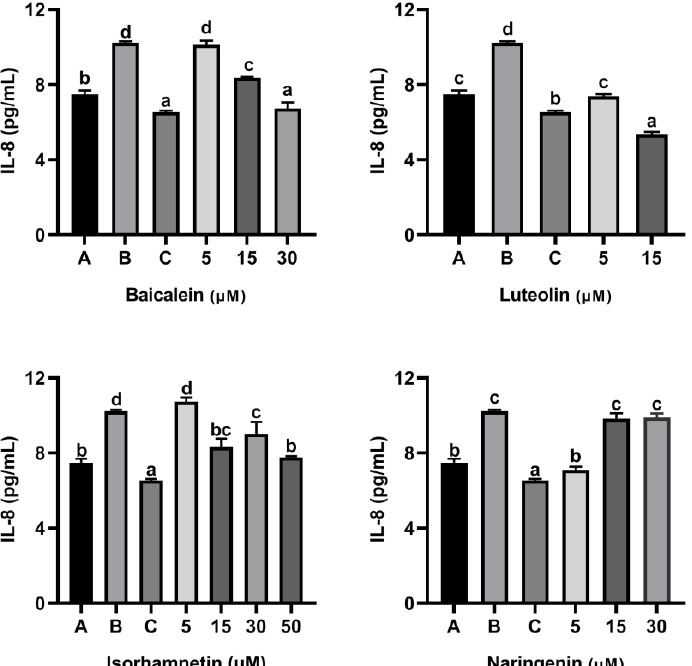
Figure 10. Effect of four flavonoids on the release of IL-8 from Caco- 2 cells induced by ω -5 gliadin- derived peptide P4. A (blank group): only Caco-2 cells; B (control group): 150 µ g/mL ω -5 gliadin- derived peptide P4+Caco-2 cells; C (positive control group): 10 nM Dexamethasone+Caco-2 cells. Note: different letters indicate significant differences between groups ( p < 0.05).